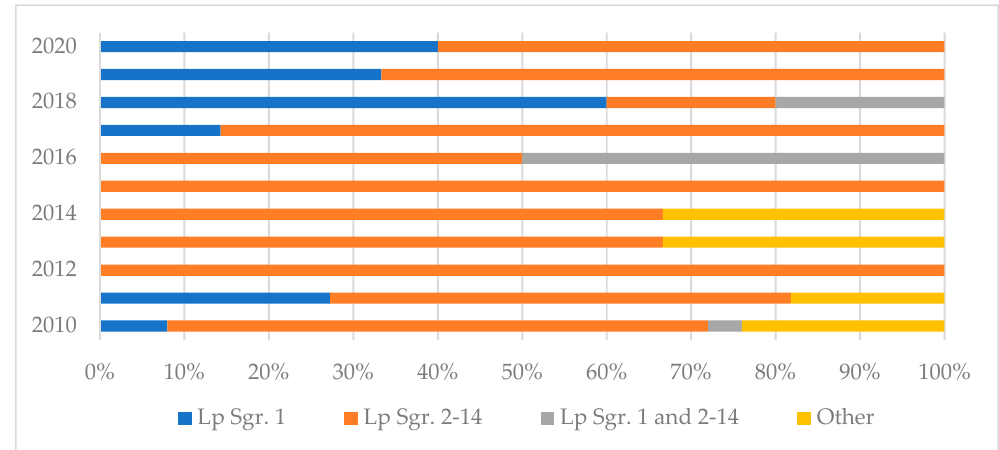
Figure 1. Bar chart showing percentages of Legionella pneumophila (Lp) Sgr. 1, Sgr. 2-14, Sgr. 1, and 2-14, and Legionella spp. (other) detected in each year of our survey.